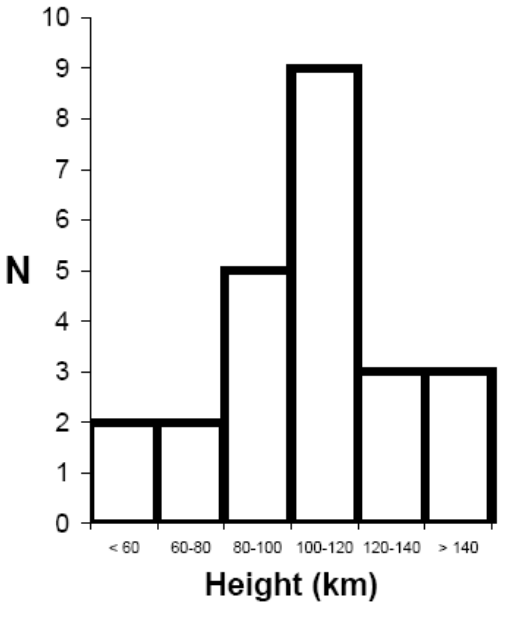
Fig. 19. Distribution of auroral heights for the 24 events selected. The corresponding elevations as measured from Treurenberg Bay ranged between 10 and 30 degrees.